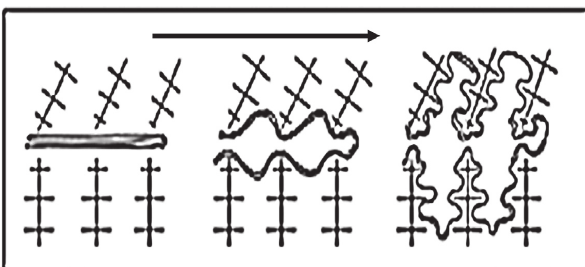
Figure 18: (a) The aluminum end phase diagram of Al-Sr binary system, (b) the aluminum end phase diagram of Al-SrAl system [37].